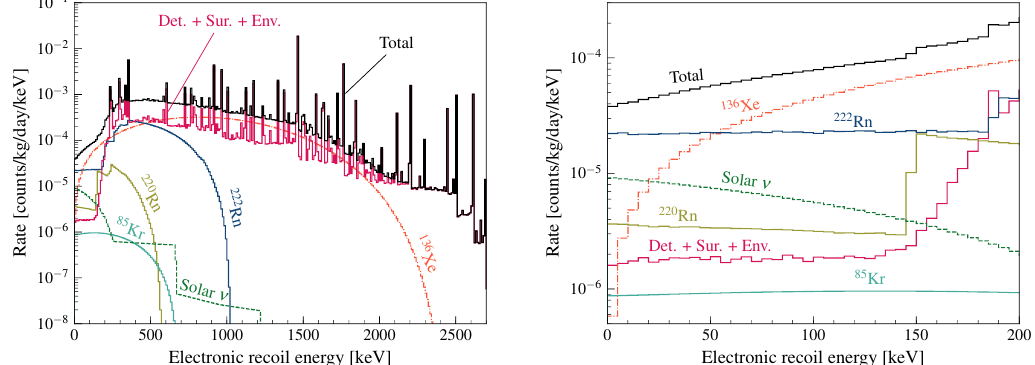
Figure 4. ( Left ) Simulated background spectra of electron recoils (ERs) in the 5.6 tonne fiducial volume for single-hit events not accompanied by any signal in the xenon skin or the outer detector. No detector efficiency, detector response, or WIMP-search region of interest cuts on S1 have been applied. ( Right ) Similar ER spectra as in the left panel, but for the 0–200 keV energy range.